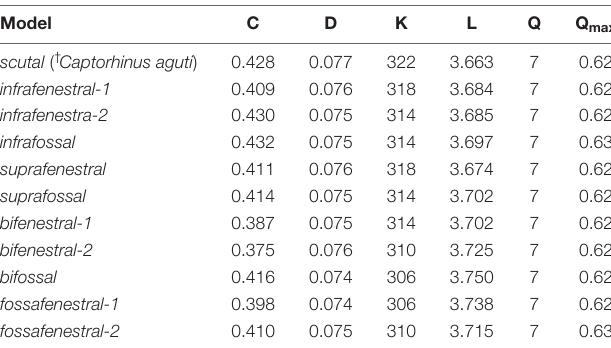
TABLE 2 | Network parameters of the analyzed networks based on the definitions theoretical background as mostly summarized by Plateau and Foth (2020).